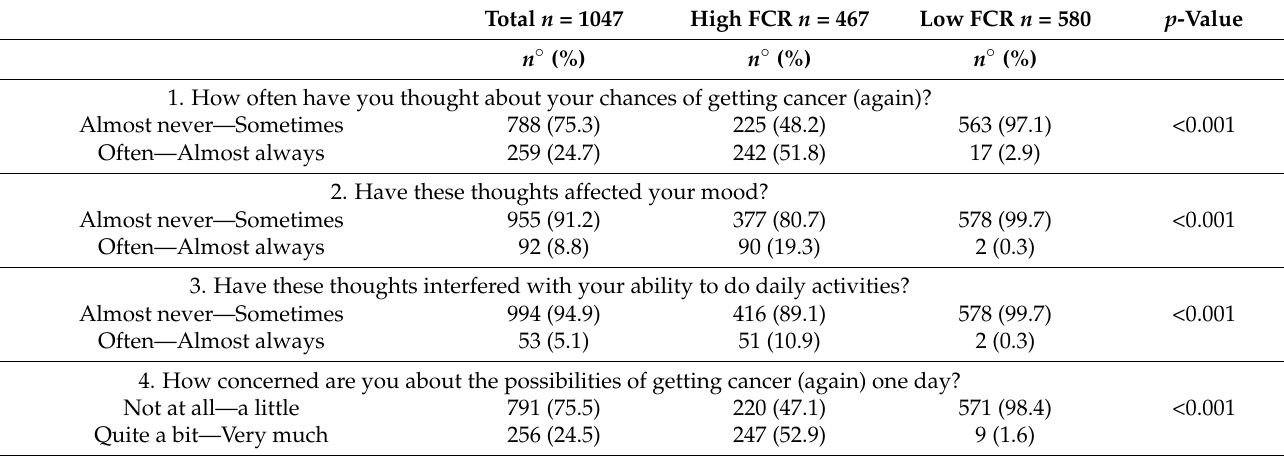
Table 2. The cancer worry